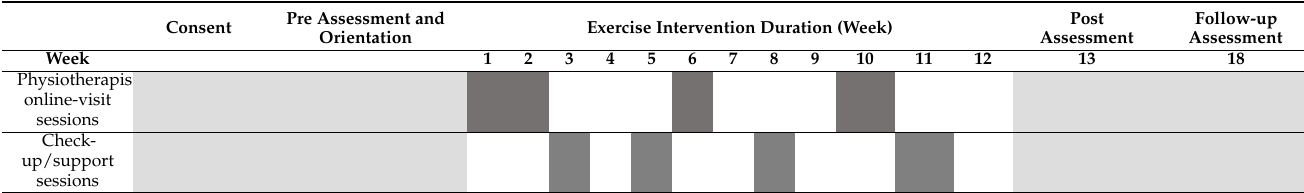
Table 1. Physiotherapist online visit and follow-up session